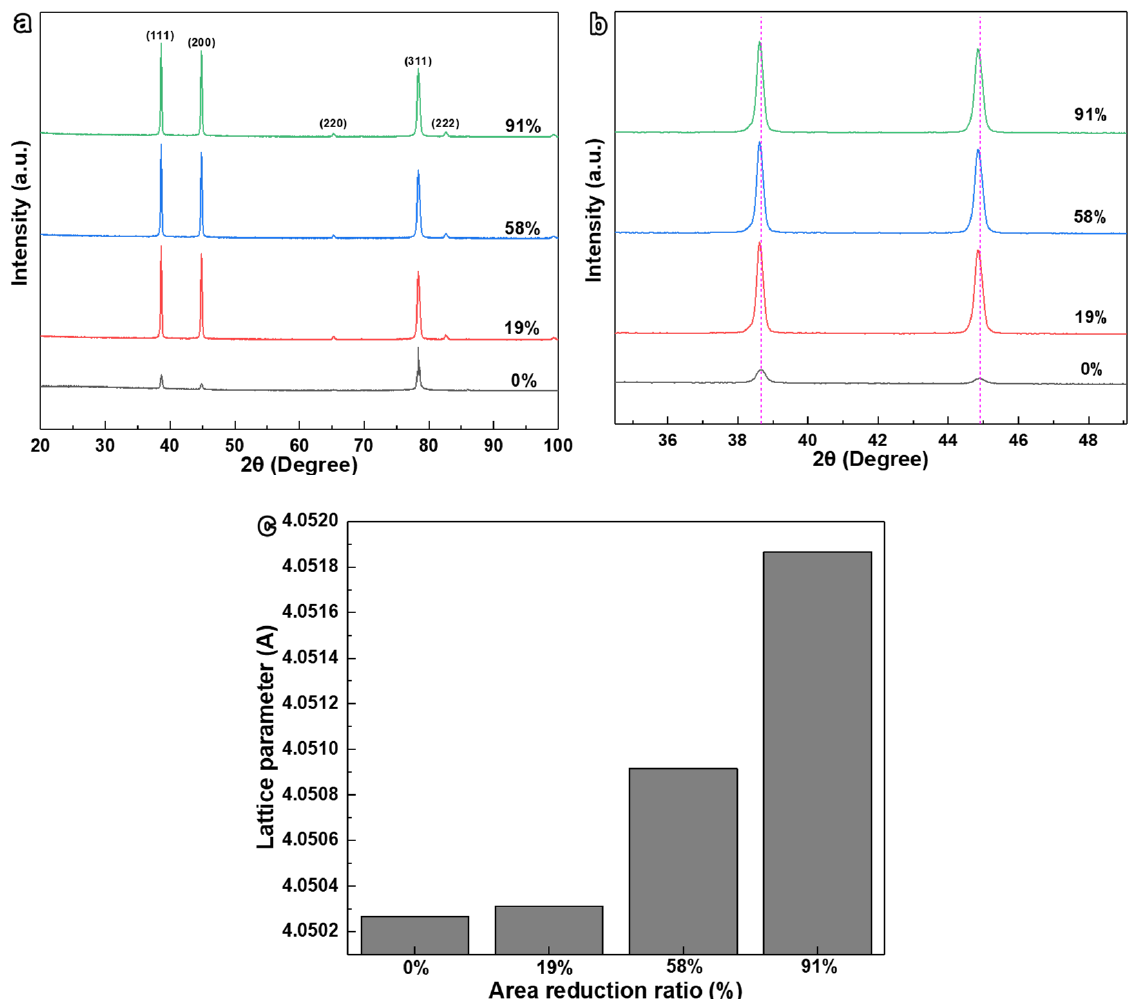
Figure 1. XRD patterns of the Al-Mg-Si-Cu alloys with different deformation amount ( a ) and their corresponding local enlarged view ( b ); histogram of the lattice parameter with different area reduction ratio ( c ).